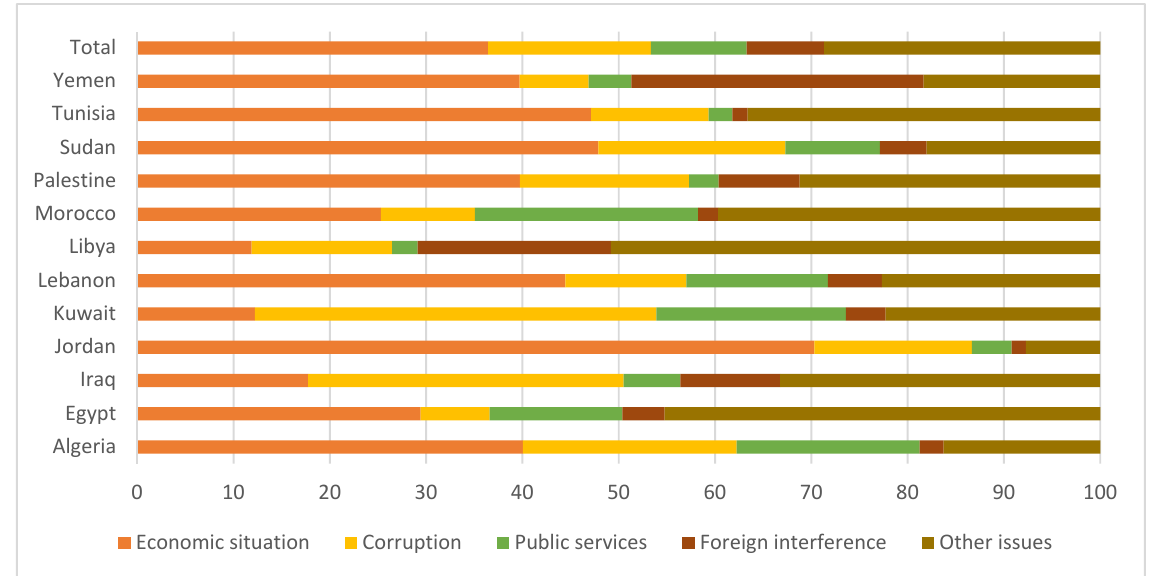
Figure 4. Most important challenges in Arab countries. Source: Arab Barometer Survey Fifth wave (2018–2019). Available online: https://www.arabbarometer.org/survey-data/data-downloads/ (accessed on 15 July 2021).